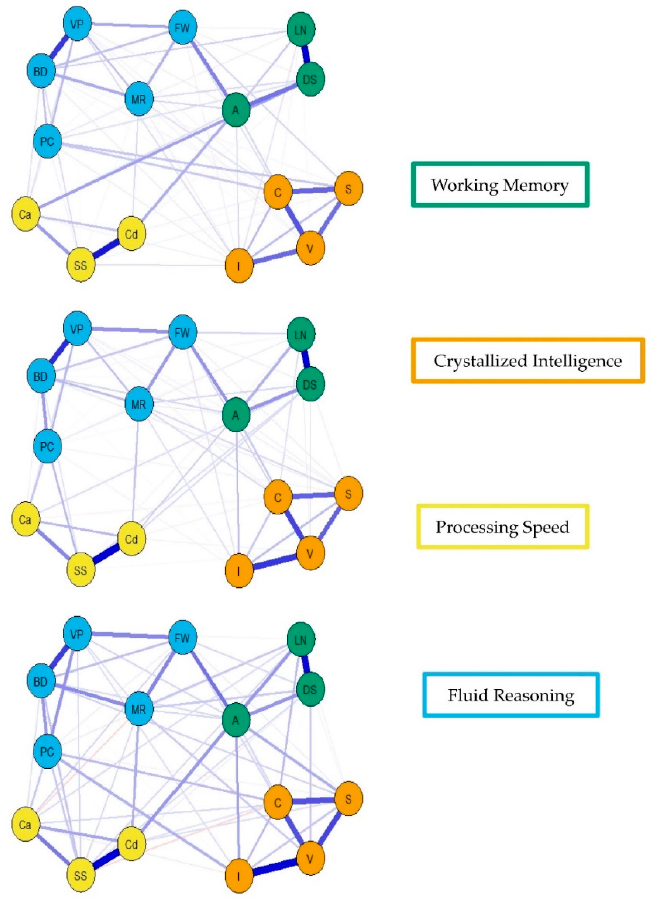
Figure 6. Weighted, undirected psychometric network model of the older group WAIS-IV correlation matrix. BD = block design; S = similarities; DS = digit span; MR = matrix reasoning; V = vocabulary; A = arithmetic; SS = symbol search; VP = visual puzzles; I = information; Cd = coding; LN = letter–number sequencing; FW = figure weights; C = comparisons; Ca = cancellation; PC = picture completion.